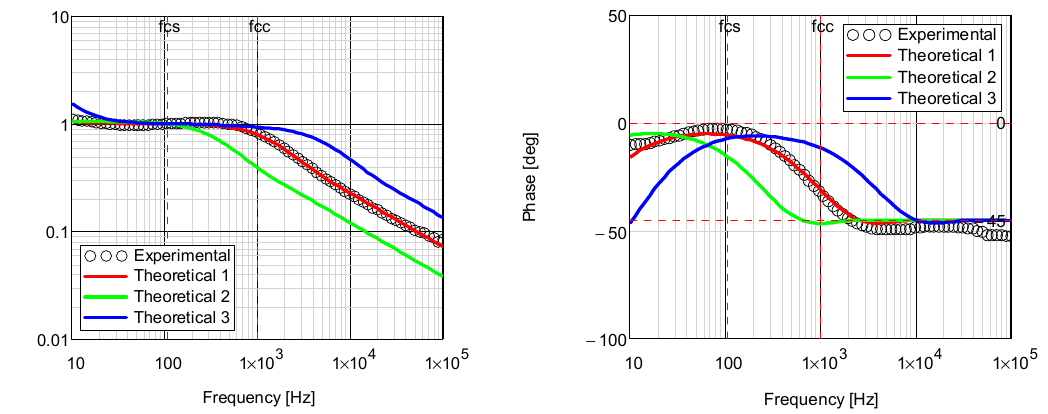
Figure 14. Theoretical and experimental PTR amplitude and phase characteristics obtained for the TMZ-III sample. The solid red line (Theoretical 1) was calculated for the best fit values of thermal parameters ( α c = 2.112 ± 0.057 cm 2 /s, λ c = 2.100 ± 0.194 W/cm · K). The solid green line (Theoretical 2) was calculated for the best fit values of thermal parameters divided by 4 ( α /4, λ /4). The solid blue line (Theoretical 3) was calculated for the best fit values of thermal parameters multiplied by 4 (4 × α , 4 × λ ). Circles are experimental data. The PTR experimental and theoretical amplitude and phase frequency characteristics of the TMZ-III + Ce(NO 3 ) 3 sample are presented in Figure 15.